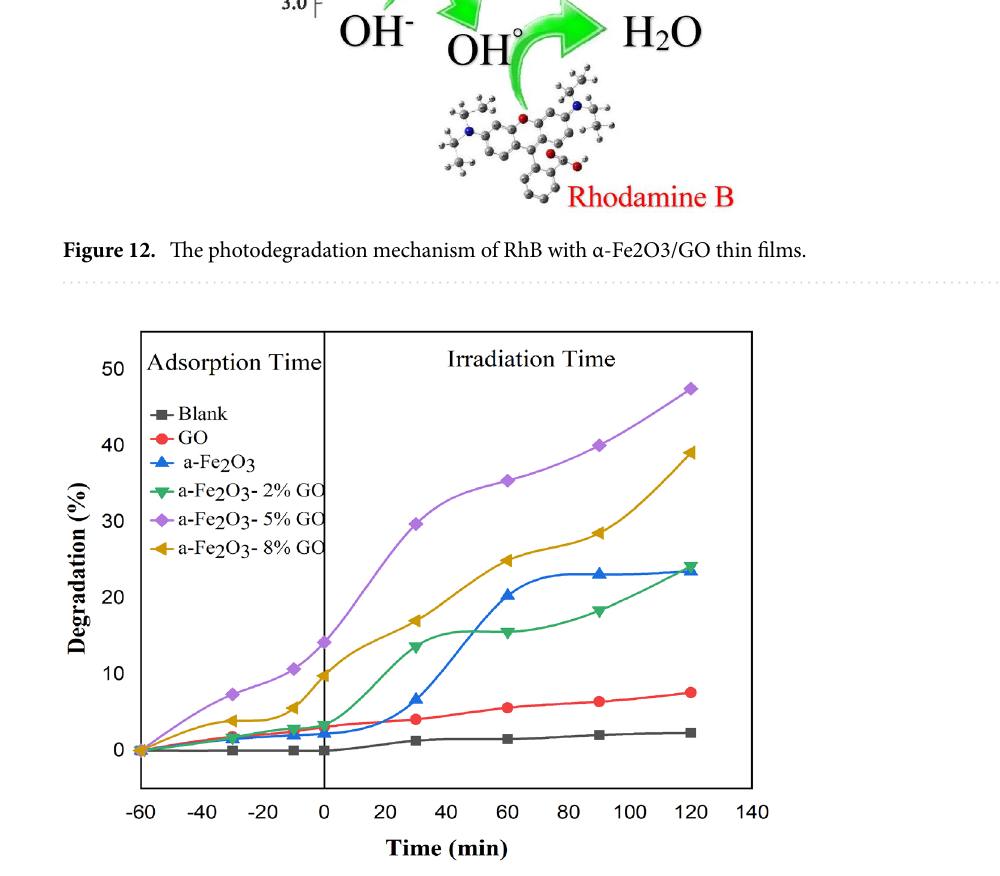
Figure 13. The result of photocatalytic process for all synthesized thin film